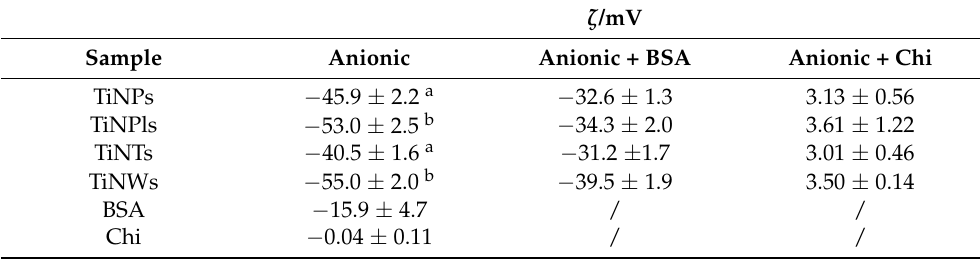
Table 3. Zeta potential of TiO 2 nanoparticles (TiNPs), nanoplates (TiNPls), nanotubes (TiNTs), nan- owires (TiNWs), bovine serum albumin (BSA), and chitosan (Chi) TiO 2 nanomaterials in anionic